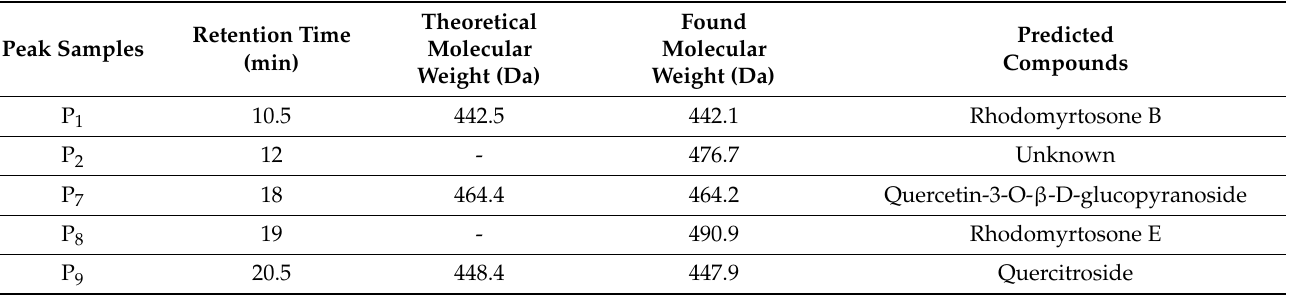
Table 1. Molecular mass of peak samples of EEEC leaves obtained from the preparative RP-HPLC via LC-MS analysis.